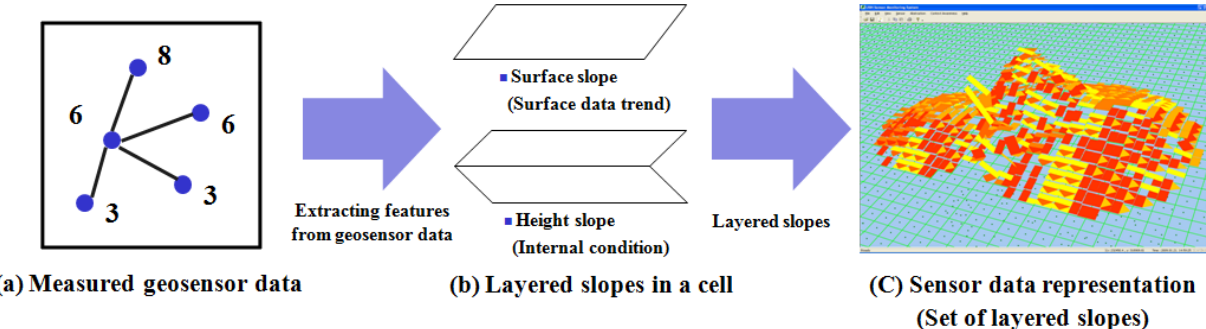
Figure 2. Sensor data representation with LSGSA.